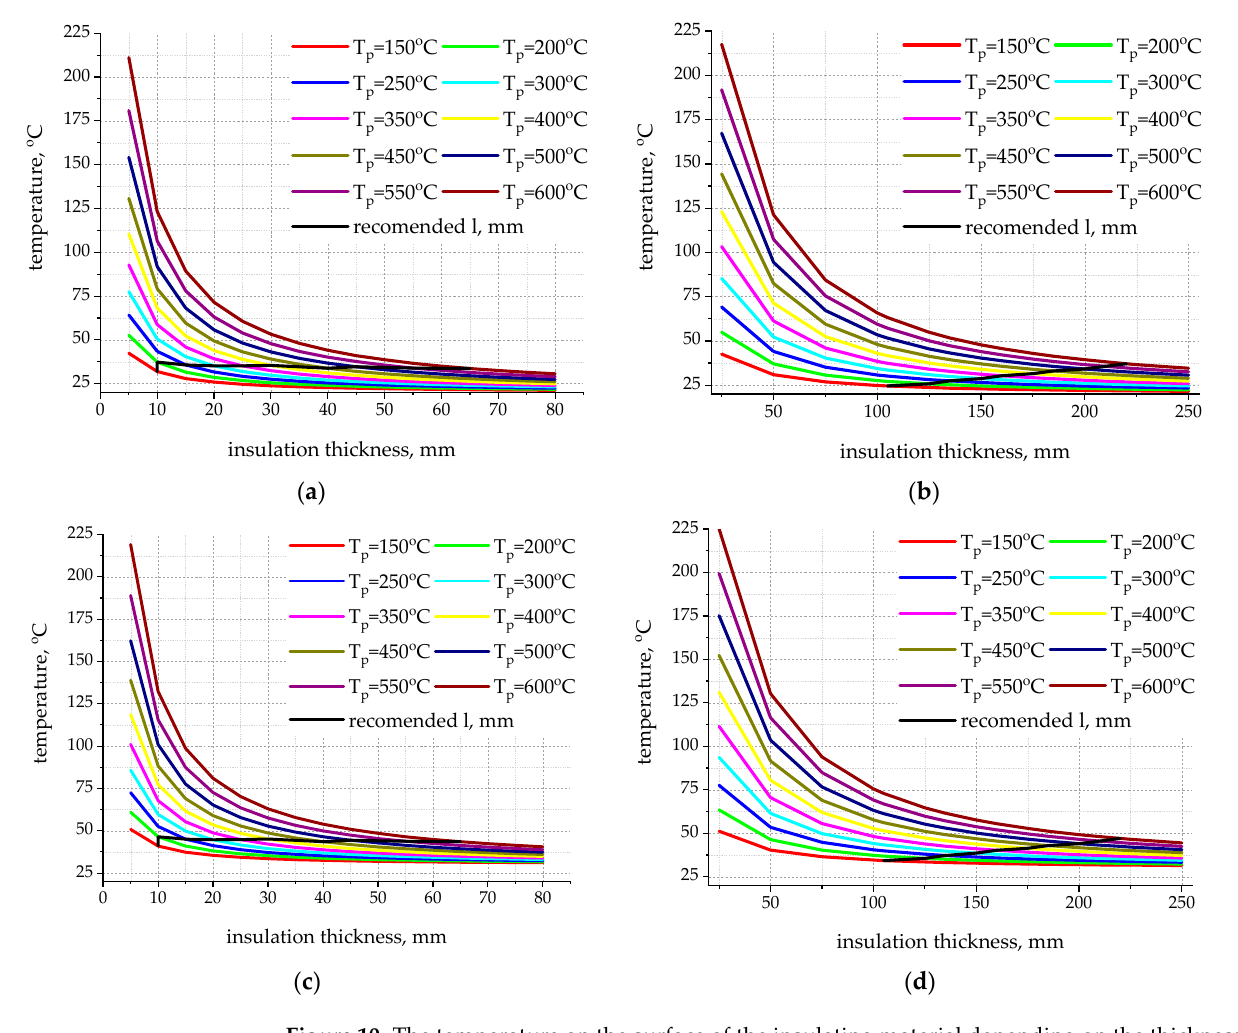
Figure 10. The temperature on the surface of the insulating material depending on the thickness of the insulation and the temperature of the heated pipe for cases T f = 20 °C and T f = 30 °C: ( a ) Aerogel, T f = 20 °C; ( b ) Basalt fiber, T f = 20 °C; ( c ) Aerogel, T f = 30 °C; ( d ) Basalt fiber, T f = 30 °C.